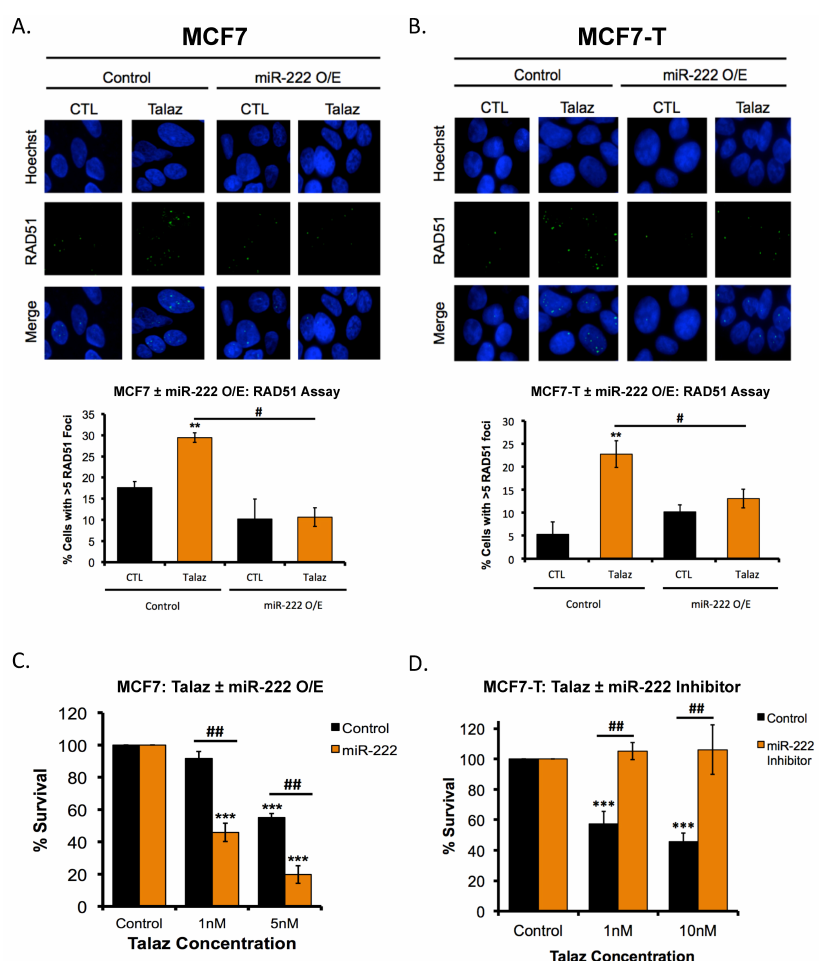
Figure 6. Tamoxifen-induced miR-222 expression mediates sensitivity to tamoxifen-talazoparib co-administration. ( A ) MCF7 and ( B ) MCF7-Tcells were treated with 1 nM talazoparib (Talaz) for 48 h in the presence or absence of miR-222 overexpression (O/E). Post treatment cells were subjected to RAD51 foci formation assay. Quantification is representative of three independent experiments. Scale bar: 20 µ m. ( C ) MCF7 cells were treated with increasing concentrations of Talaz for 48 h, with